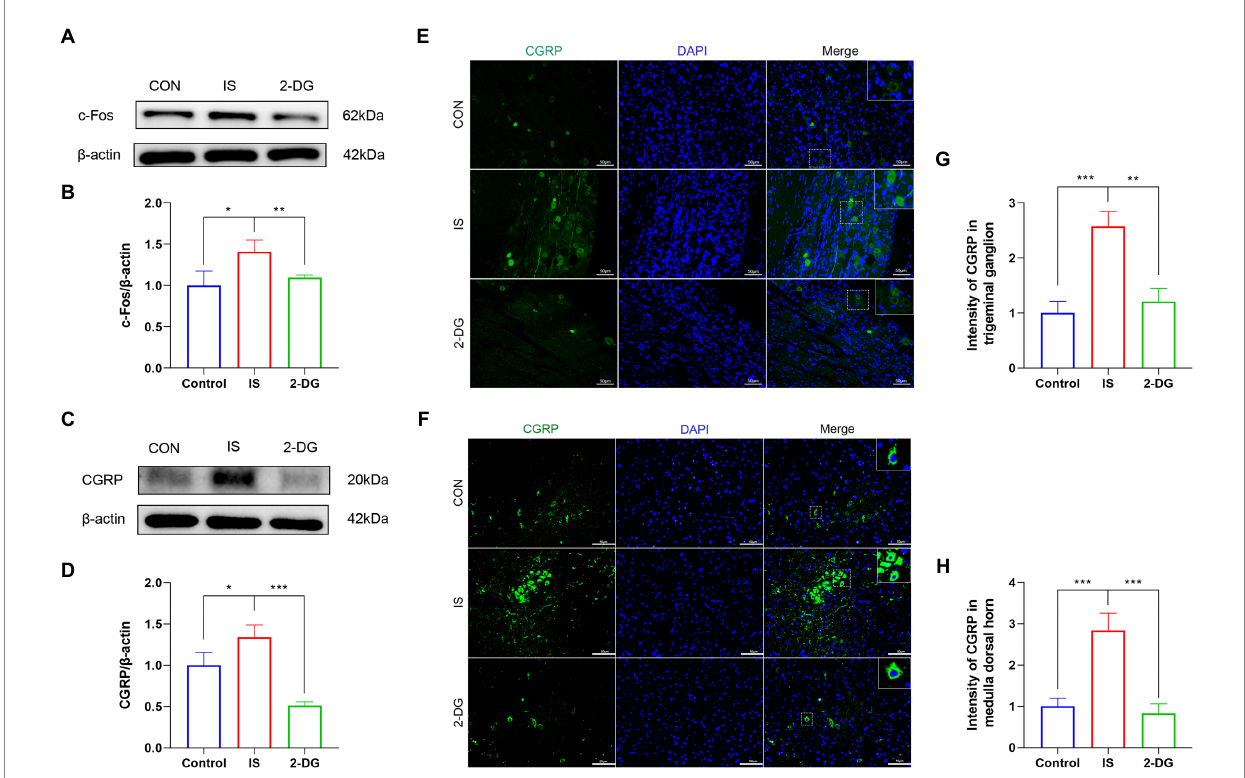
FIGURE 4 2-DG inhibited IS-induced upregulation of c-Fos and CGRP protein. (A) WB of c-Fos protein in the medullary dorsal horn. (B) Infusion of IS increased c-Fos protein levels in the medulla dorsal horn, and the expression of c-Fos was significantly decreased in the 2-DG group compared with the IS group. Data were expressed as mean ± SD ( n = 3 per group). * p < 0.05, ** p < 0.01. (C) WB of CGRP protein in the medullary dorsal horn. (D) Infusion of IS increased CGRP protein levels in the medulla dorsal horn, and the expression of CGRP was significantly decreased in the 2-DG group compared with the IS group. Data were expressed as mean ± SD ( n = 3 per group). * p < 0.05, *** p < 0.001. (E) The immunoreactivity of CGRP in the trigeminal ganglion. (F) The immunoreactivity of CGRP in the medullary dorsal horn. (G) Quantification of CGRP immunofluorescence intensity in trigeminal ganglion. Data were expressed as mean ± SD ( n = 3 per group). ** p < 0.01, *** p < 0.001. (H) Quantification of CGRP immunofluorescence intensity in medulla dorsal horn. Data were expressed as mean ± SD ( n = 3 per group). *** p <